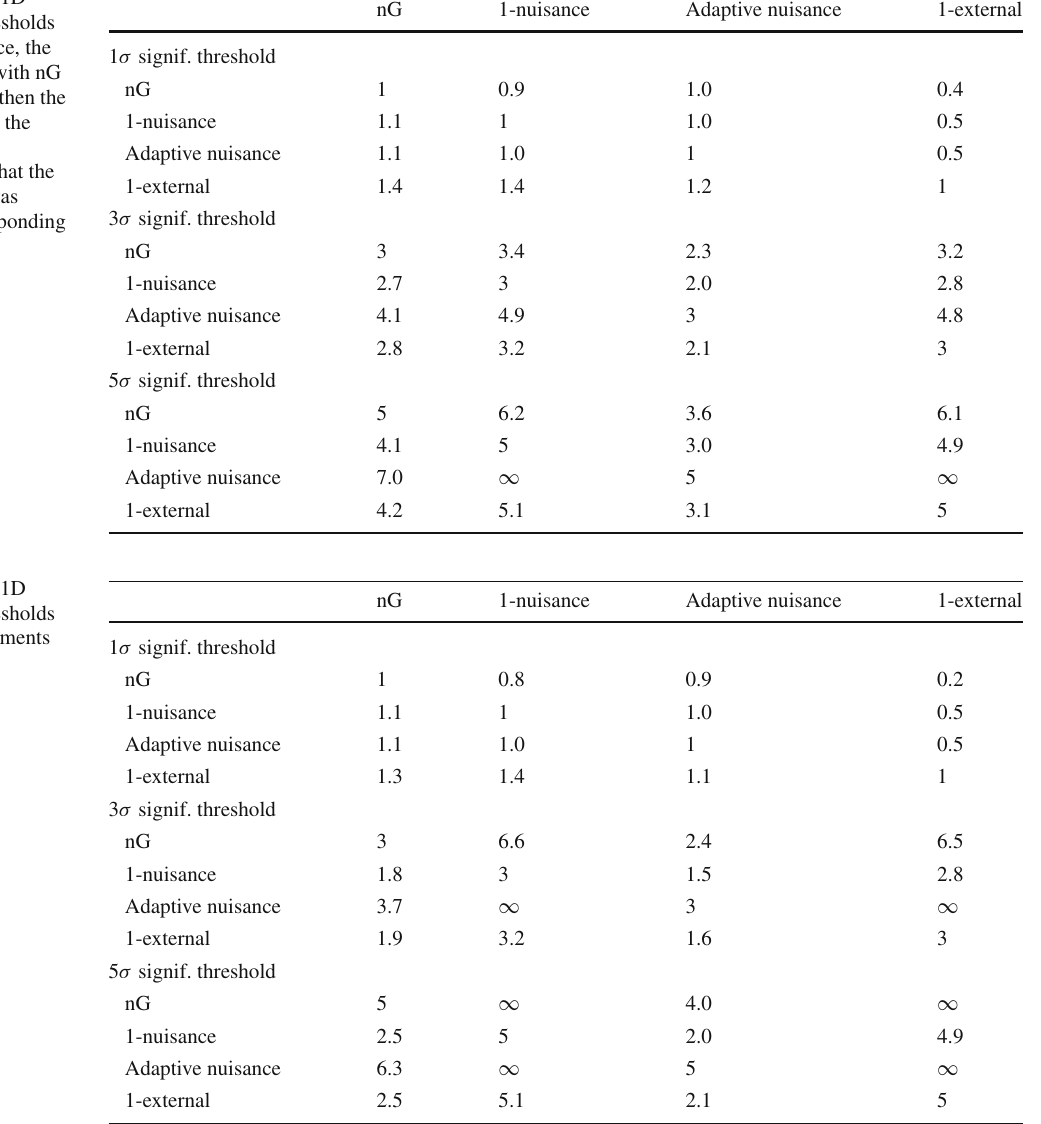
1 , 3 , 5 σ significance thresholds